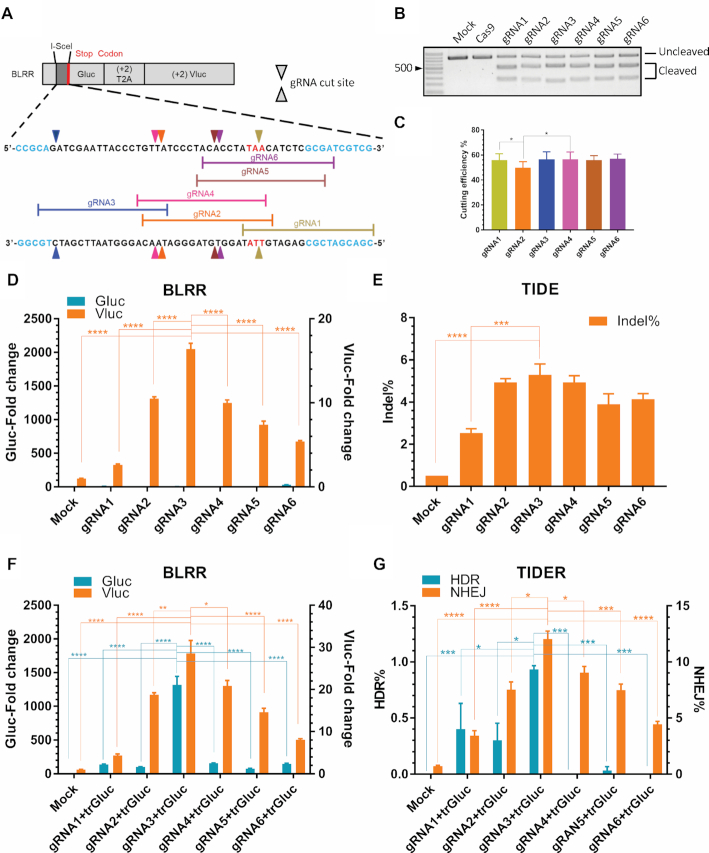
The BLRR assay can measure gRNA editing efficiency with high sensitivity. (A) Schematic diagram of six gRNA target sites of the BLRR. Triangles indicate gRNA cut sites; yellow, gRNA1; orange, gRNA2; dark blue, gRNA3; pink, gRNA4; brown, gRNA5; purple, gRNA6. The Gluc sequence is highlighted in light blue. A stop codon within the I-SceI insertion is highlighted in red. The in silico editing score of each gRNA is shown in Supplementary Table S2. (B) In vitro cleavage assay demonstrating different gRNA yields with varying levels of Cas9-mediated DSB. Cas9 and mock negative controls showed no detectable DSB. Representative data from three independent experiments are shown. (C) Statistical analysis of in vitro cleavage assays showing gRNA2 exhibiting the lowest editing efficiency, which corroborates the predicted scores (Supplementary Table S2). Data are presented as mean ± SEM of three independent experiments. (D) BLRR analysis showing differences in gRNA editing efficiency in cells. BLRR cells were transfected with individual Cas9-gRNA pairs, and Cas9-gRNA3 (gRNA3) and Cas9-gRNA1 (gRNA1) exhibited the highest and lowest editing efficiency, respectively. BLRR signals were normalized against cell viability and are shown as fold change relative to the mock control (mean ± SEM). A representative experiment composed of three independent experiments with three biological replicates is shown. (E) TIDE analysis of cells from (D) showing a similar trend in indel% as the BLRR assay. gRNA3 and gRNA1 exhibited the highest and lowest indel%, respectively. Data are presented as mean ± SEM of three biological replicates. (F) The BLRR assay can determine significant differences in HDR and NHEJ activities between different Cas9-gRNA pairs. BLRR cells were transfected with trGluc and individual Cas9-gRNA pairs at a 1:1 ratio. gRNA3 exhibited the highest Gluc and Vluc signals, whereas the other gRNAs all showed minimal Gluc activity. BLRR signals were normalised against cell viability and are presented as the fold change relative to the mock control (mean ± SEM of three biological replicates). A representative experiment composed of three independent experiments with three biological replicates is shown. (G) TIDER analysis of cells from (F) showing a similar trend for NHEJ and HDR events as reported by the BLRR assay. gRNA3 yielded the highest HDR% and NHEJ% among the gRNAs. Data are presented as mean ± SEM of three biological replicates. Significance was calculated using one-way ANOVA as indicated, followed by Tukey's post-hoc test (*P < 0.05, **P < 0.01, ***P < 0.001, ****P < 0.0001).